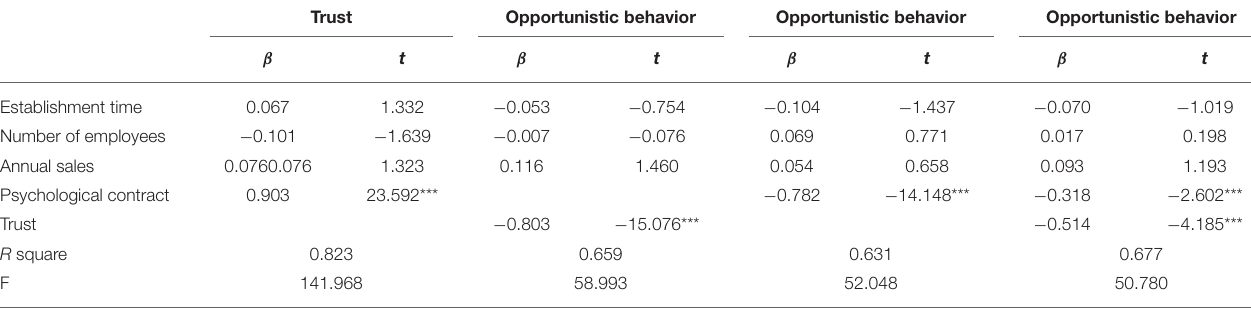
TABLE 4 | Mediation effect results of trust.